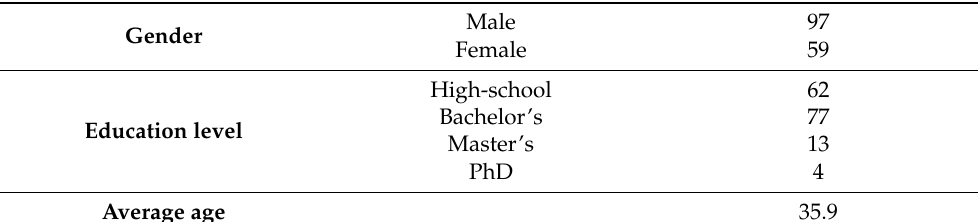
Table 1. Subjects’ demographic information.